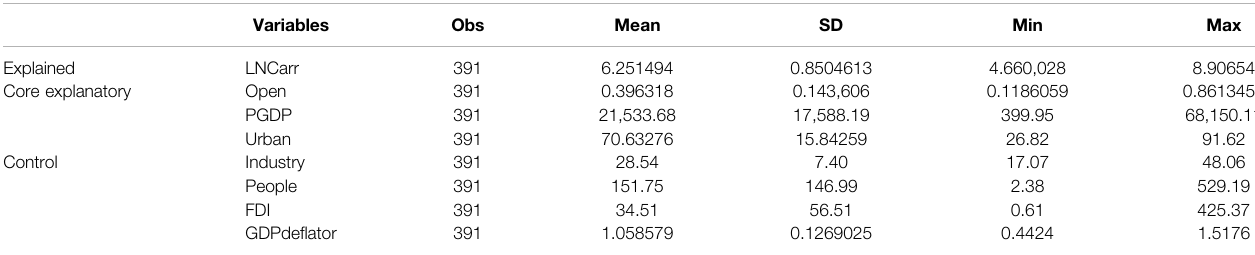
TABLE 1 | Descriptive statistics for the considered